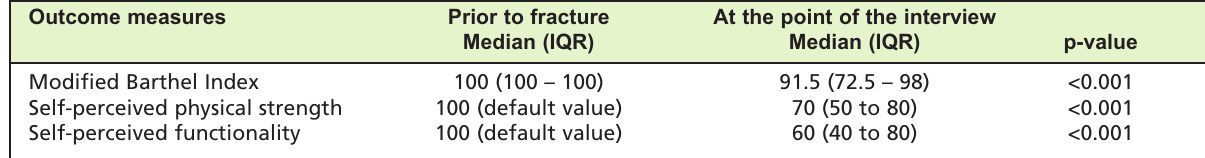
Comparison of outcome measures before and after hip fracture (minimum after six months) Table II: